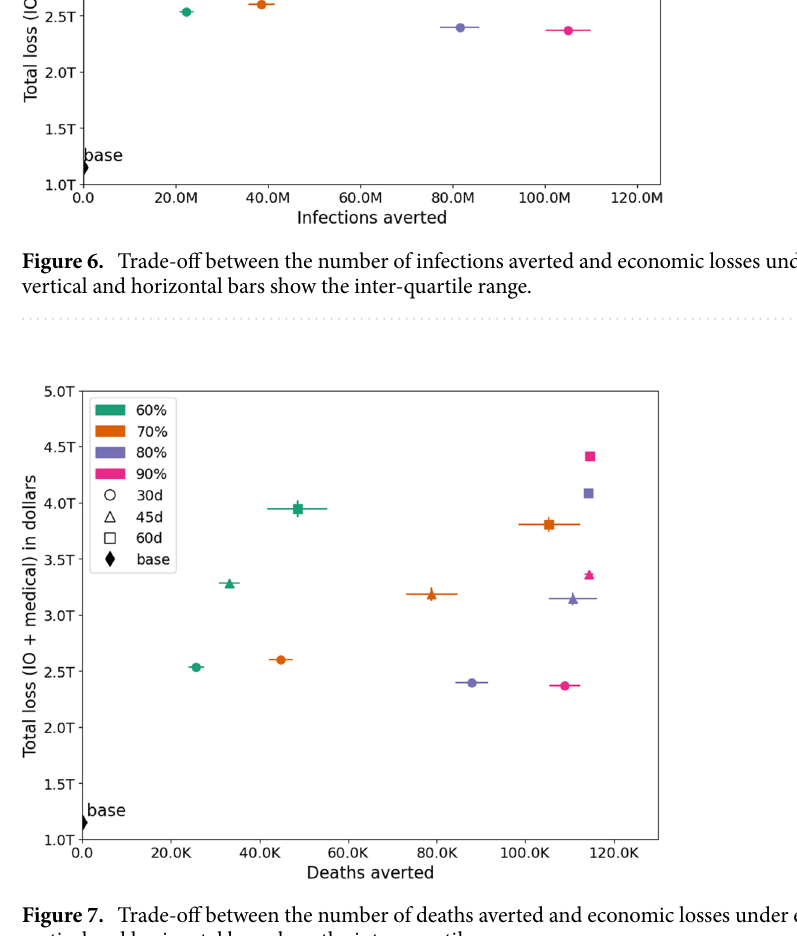
Figure 7. Trade-off between the number of deaths averted and economic losses under each scenario. The vertical and horizontal bars show the inter-quartile